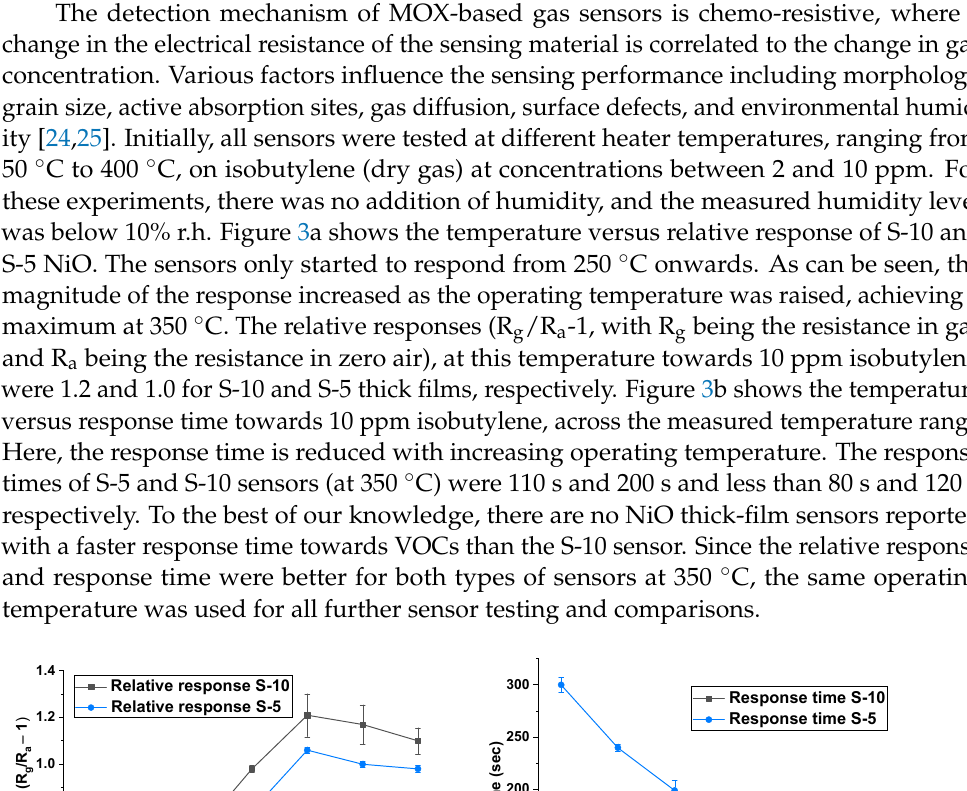
Figure 2. Gas-rig setup.